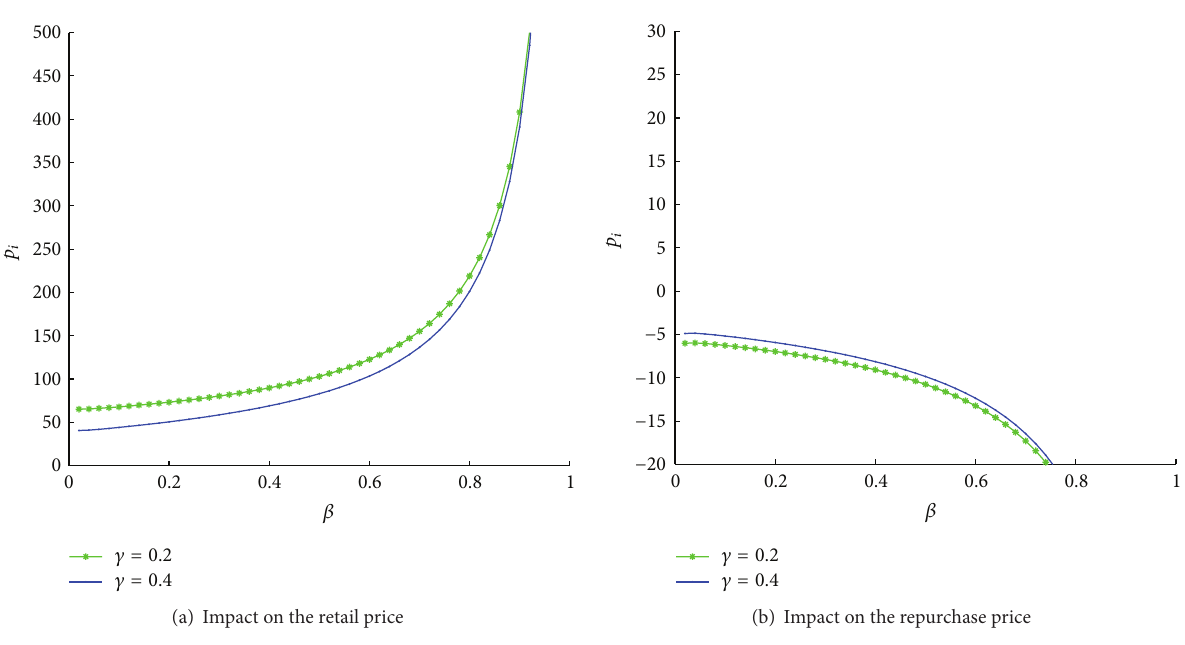
Figure 4: Impact of the retailing and recycling substitution effects on price in model 𝐷